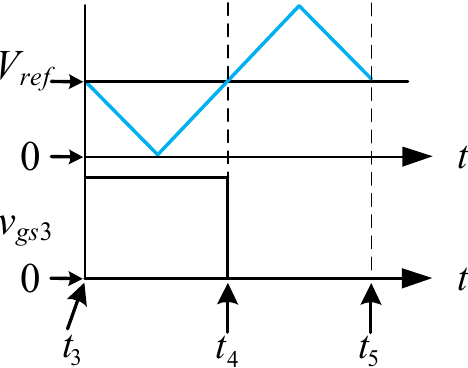
Only the switch S 10 is switched as in Figure 10.